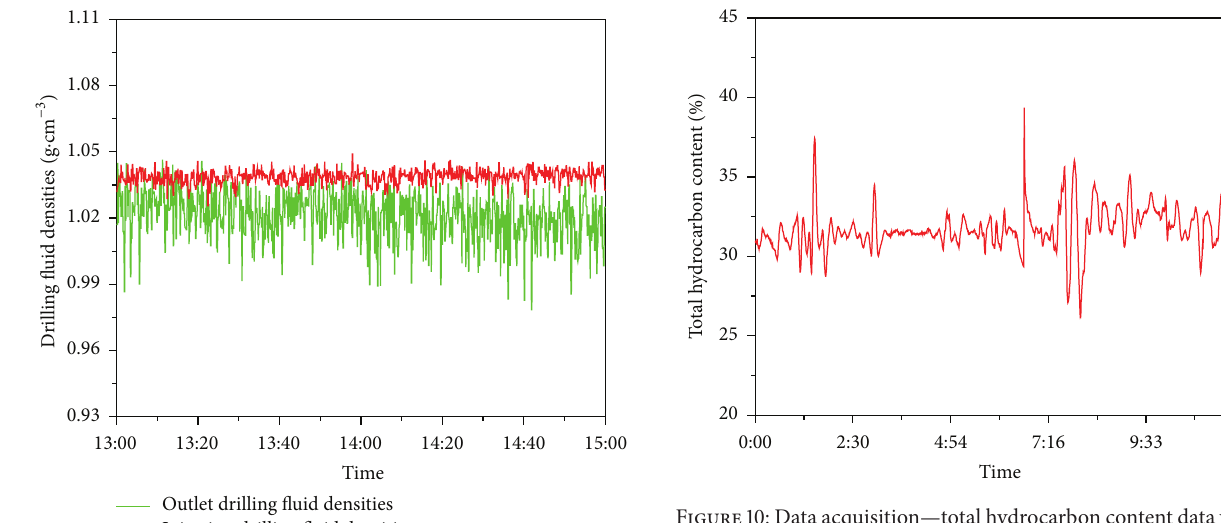
Figure 10: Data acquisition—total hydrocarbon content data versus time